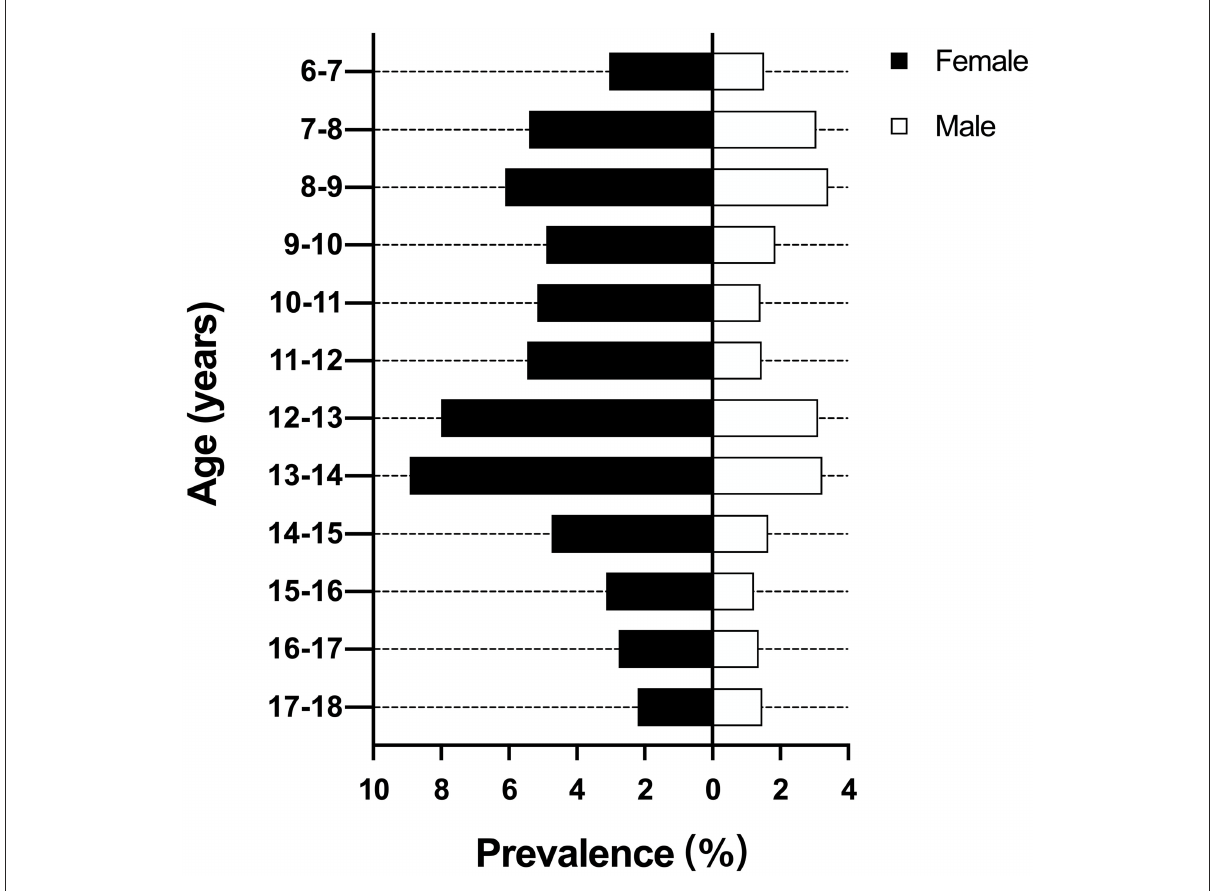
FIGURE2 Prevalence of scoliosis according to age and